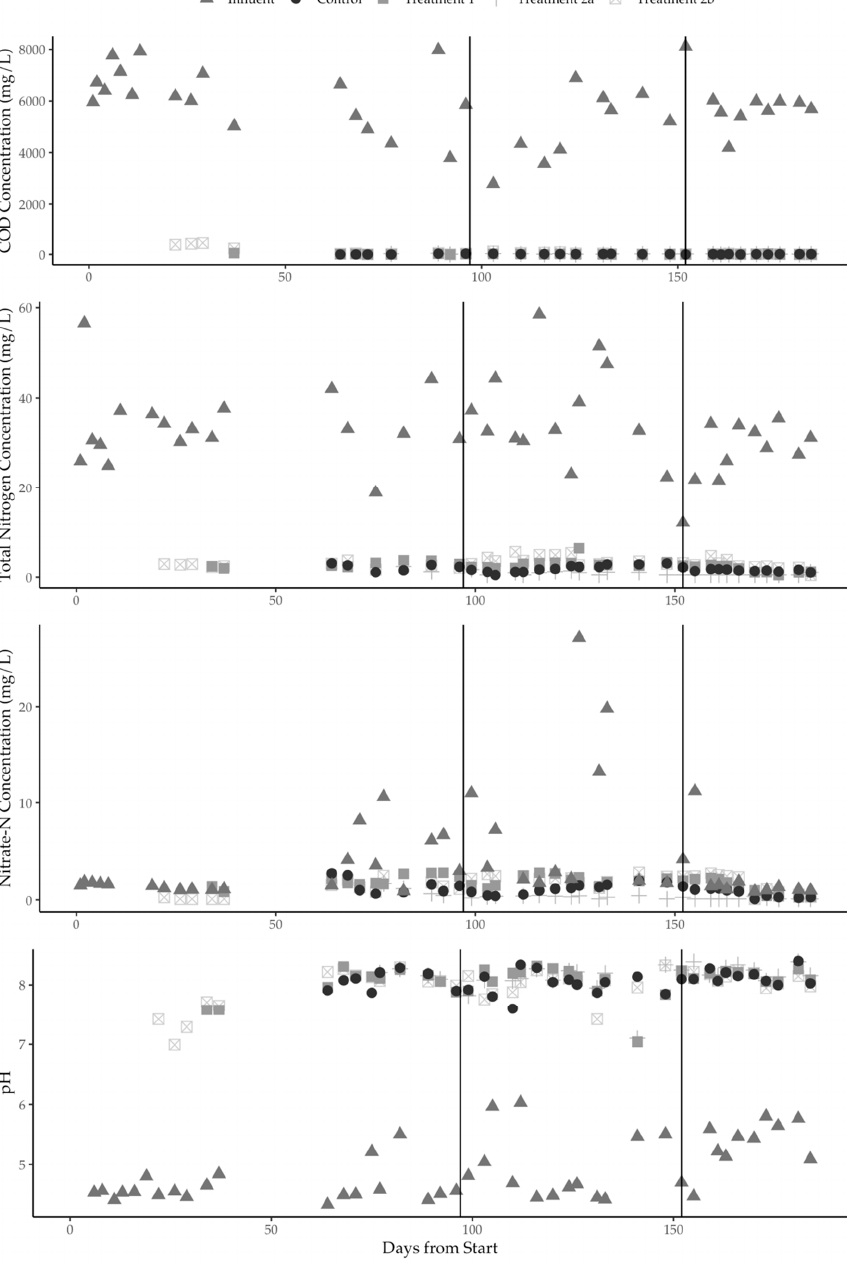
Figure 3. Variation of influent and e ffl uent concentrations in each treatment system. Solid vertical lines separate the three phases. E ffl uent results below the detectable limit were plotted at half the detectable